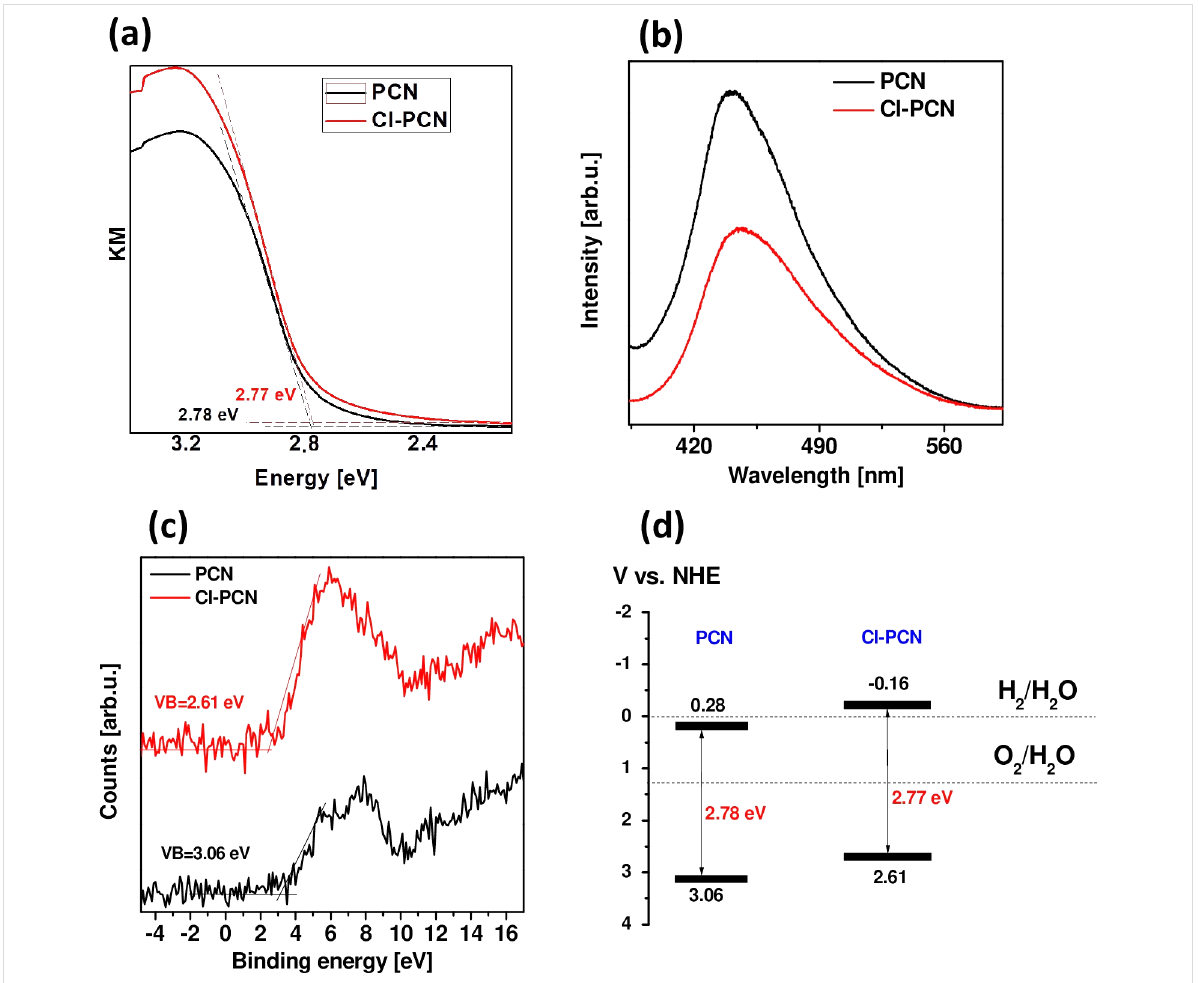
Figure 8: (a) DRS spectra, (b) PL emission spectra, (c) valence band (VB) XPS spectra, and (d) band diagram of PCN and